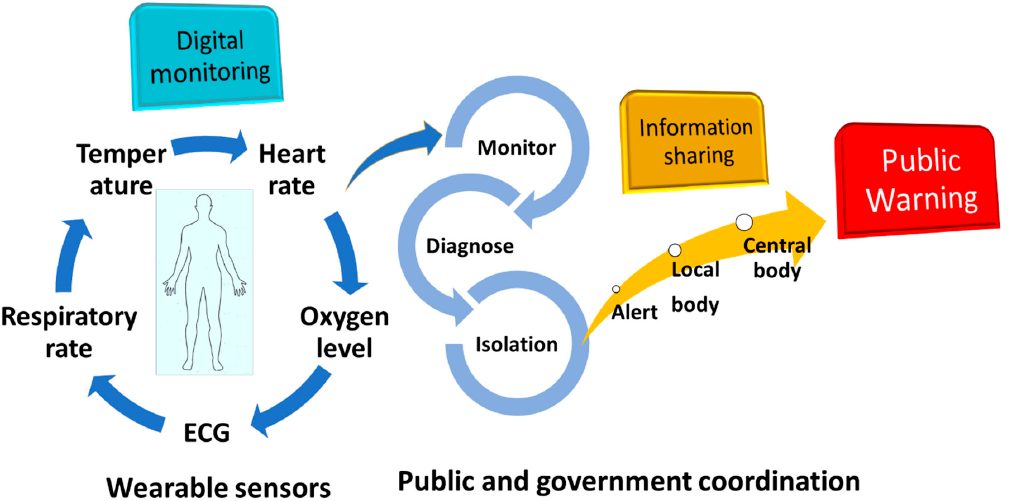
Figure 2. Role of wearable sensor technology for personal health monitoring in coordination with government for public healthcare management. ECG: electrocardiogram.